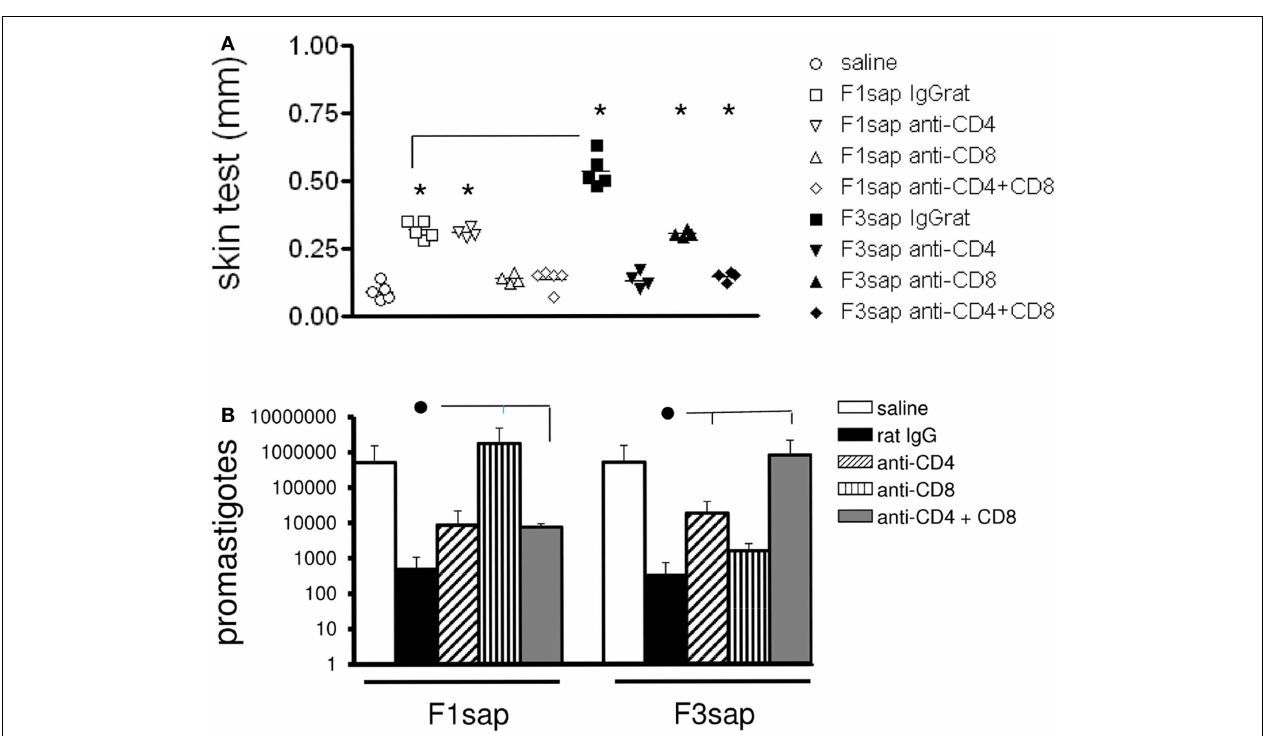
one experiment with four to five mice per treatment group are shown. * p < 0.05, different from the saline controls and horizontal lines represent significant differences between the two vaccines (A) . In the limiting dilution assay (B) bars represent the number of promastigotes ± SD in each treatment (one experiment with four to five mice per treatment). • Horizontal lines express significant differences from the F1sap- or F3sap-vaccinated treated with rat IgG only.